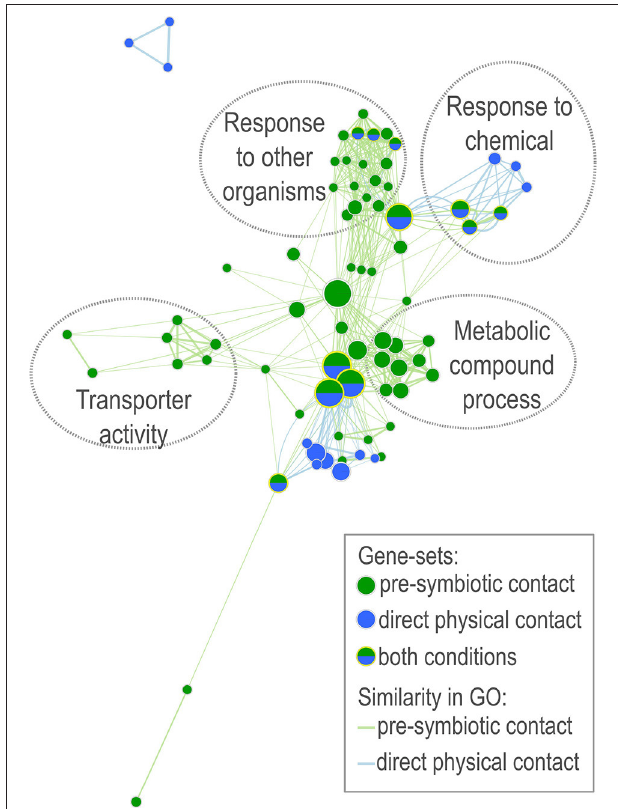
FIGURE 6 | Network analysis of early transcriptomic responses of E. grandis to P. microcarpus. The network illustrates the gene ontology (GO) enrichment resulted with transcriptome data derived from E. grandis roots after two different kind of contact interaction with mycelia of P. microcarpus —pre-symbiotic contact (green) and direct physical contact (blue). Only significantly up-regulated genes in comparison to untreated control roots with log(fold change) > 5 are included. Circled with dotted-lines are clusters of enriched gene-sets with related GO functions. Node size represents the number of genes within the enriched gene-set of certain GO ( q < 0.1). Edges connect gene-sets with overlapping genes (similarity coefficient > 0.5). Edge thickness and length are correlated with the similarity coefficient between